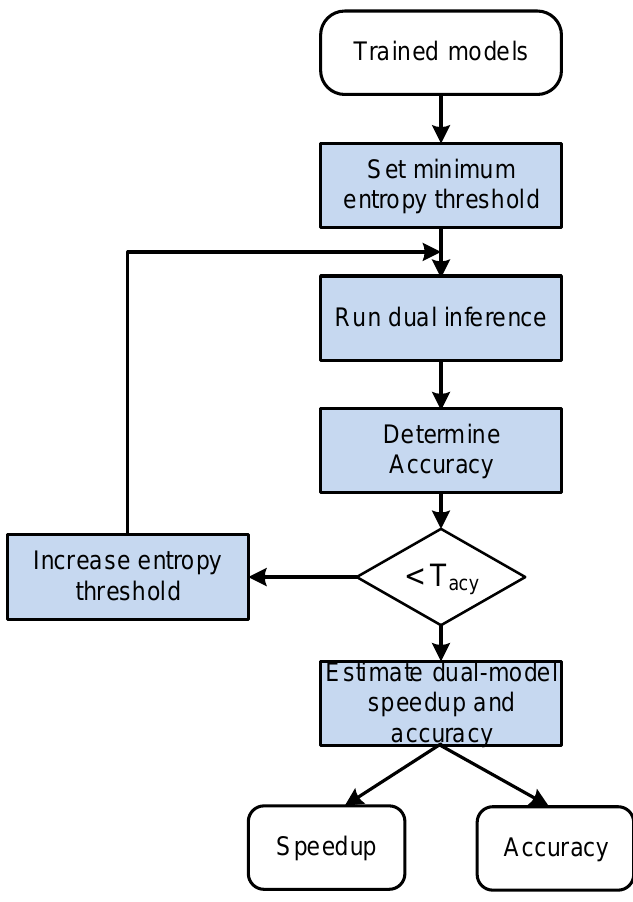
Figure 2. Design flow used to find the best dual